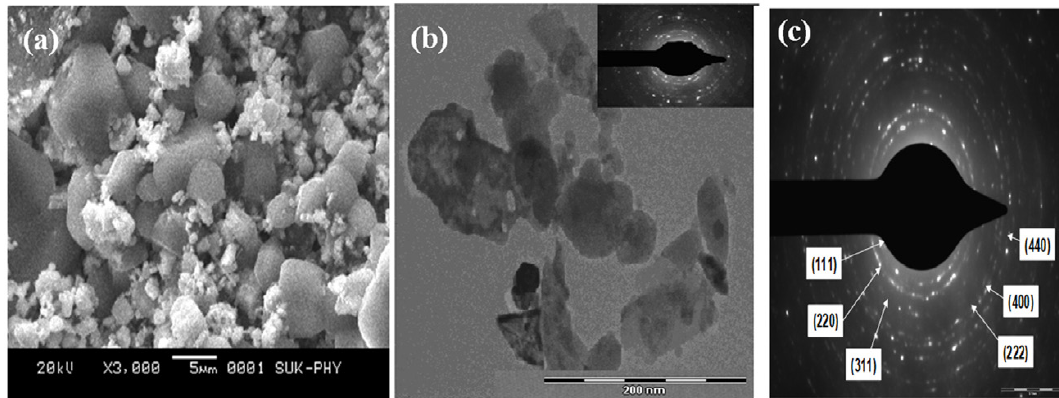
Fig.5. (a) Scanning electron micrograph (b) Transmission electron micrograph (c) SAED pattern for Mg